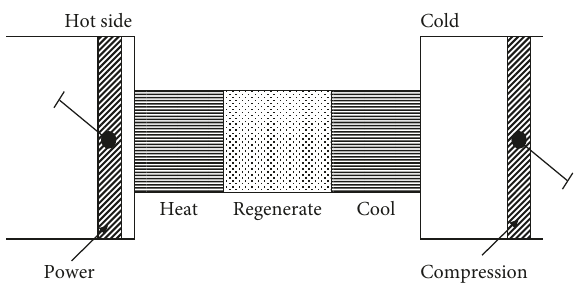
Figure 2: Schematic of alternative design (Stirling cycle), with a regenerator inside the two-piston